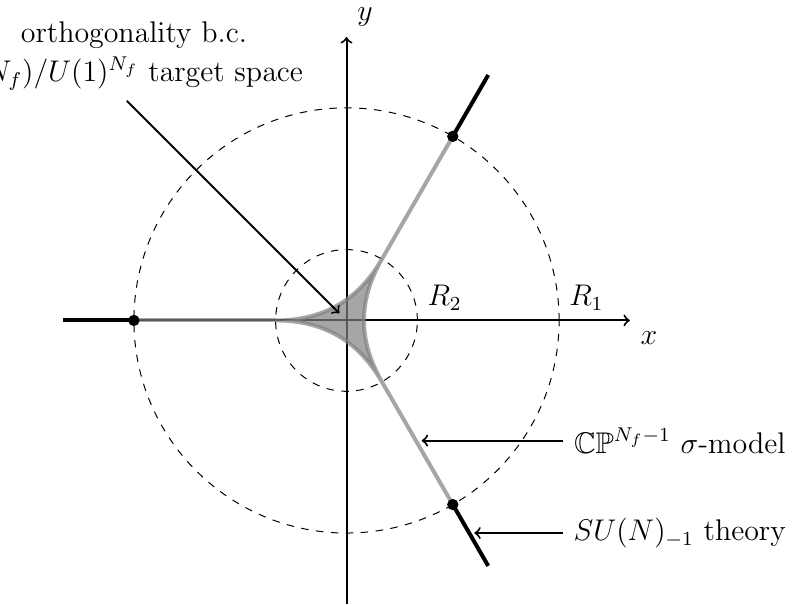
Figure 3: The dynamics in the interior for a space-dependent mass m = (cid:34) re i α Λ 2 = 3. There are N with (cid:34) (cid:28) 1 when N interfaces continuing from infinity to the f f ∼ 1 / ( (cid:34) Λ ) , the theories on the origin. When the interfaces pass through radius R 1 interfaces undergo a transition from an SU ( N ) − Chern-Simons theory to a (cid:67)(cid:80) N f − 1 1 sigma model with a Wess-Zumino term which leads to 1 + 1 dimensional chiral modes localized at the transition interfaces. The interfaces form an interface junction of ∼ 1 / ( (cid:34) 1 / 3 Λ ) at the origin. On the interface junction, one should impose an size R 2 (cid:80) Φ † Φ = δ (cid:67)(cid:80) N f − 1 sigma models. orthogonality boundary condition for the N Ib ab f I Ia This reduces the target space on the junction from N independent copies of (cid:67)(cid:80) N f − 1 f ) / U ( 1 ) N f . The flag sigma model on the junction manifold to the flag manifold U ( N f is supplemented by a Wess-Zumino term S defined in WZW